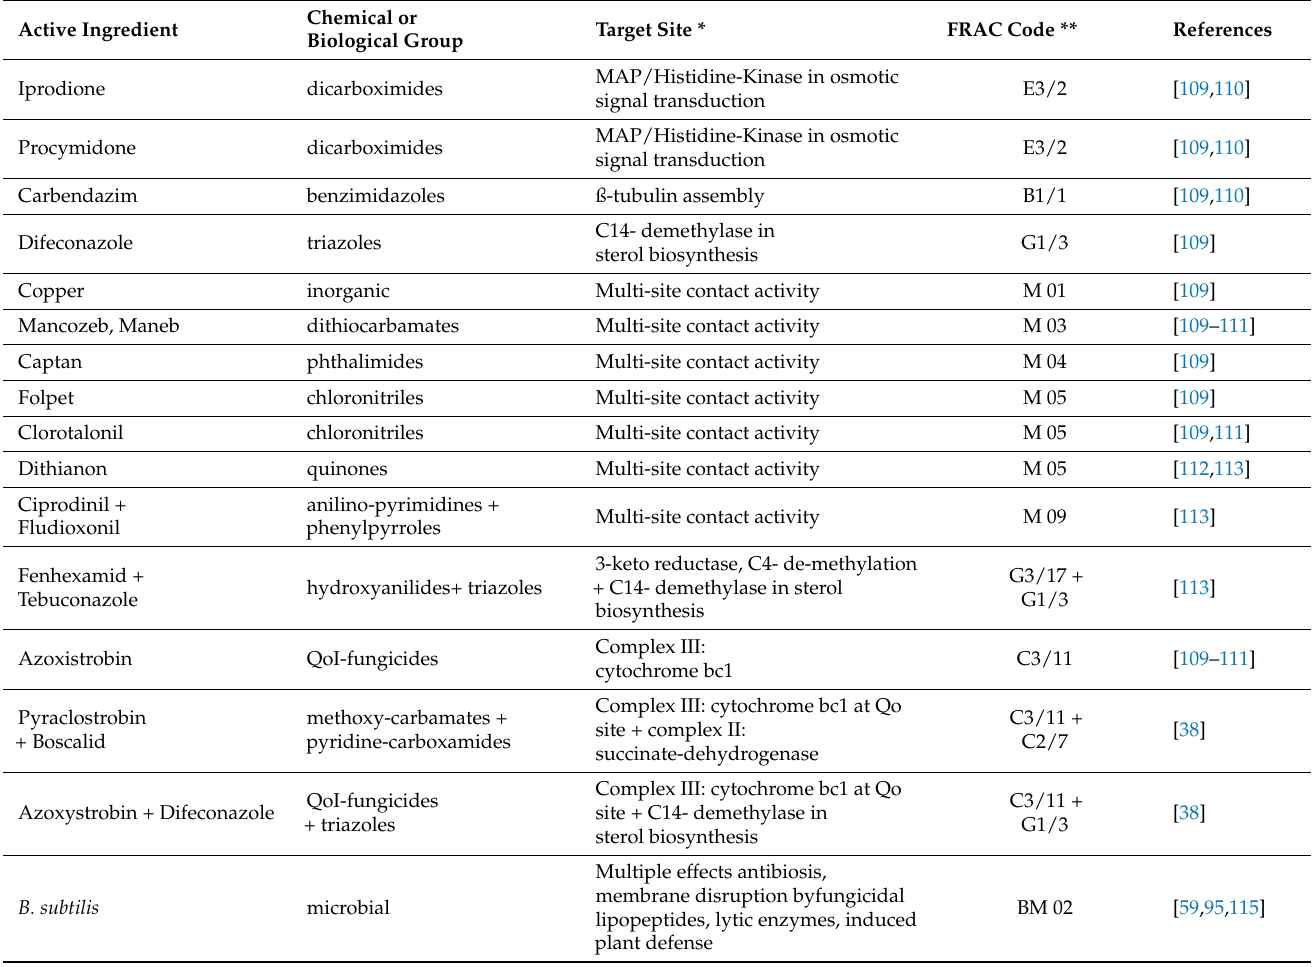
Table 4. Fungicides and bioproducts reported for the control of lupin